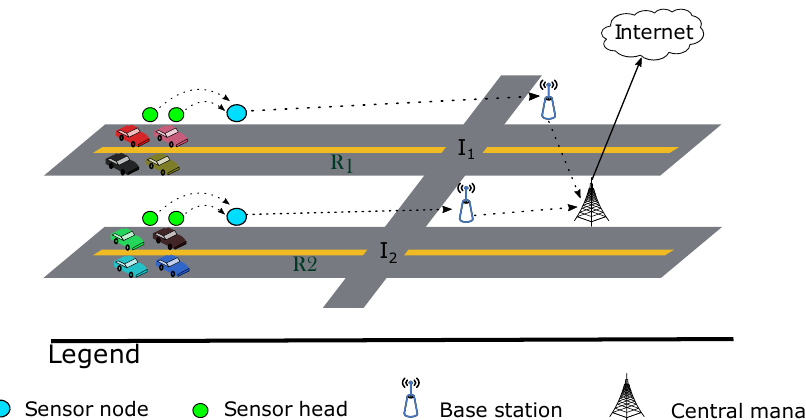
Figure 4. Example of two intersections that can be running the generalized nondeterministic batch Petri net (GNBPN) model.